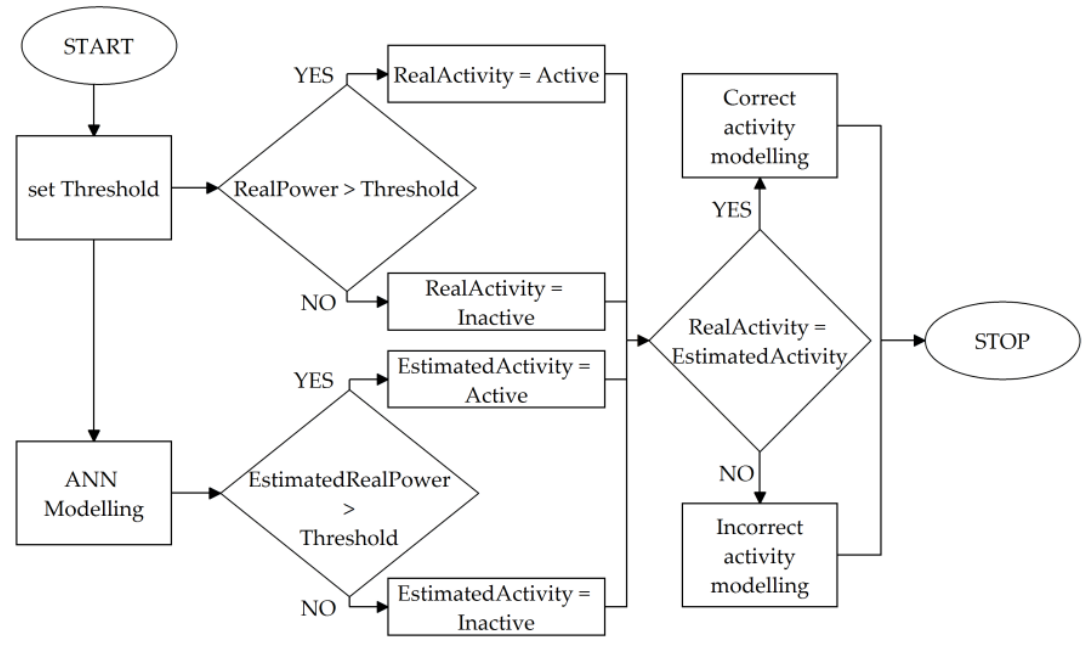
Figure 6. Algorithm for classifying real and estimated activity by external classifier on the basis of threshold.